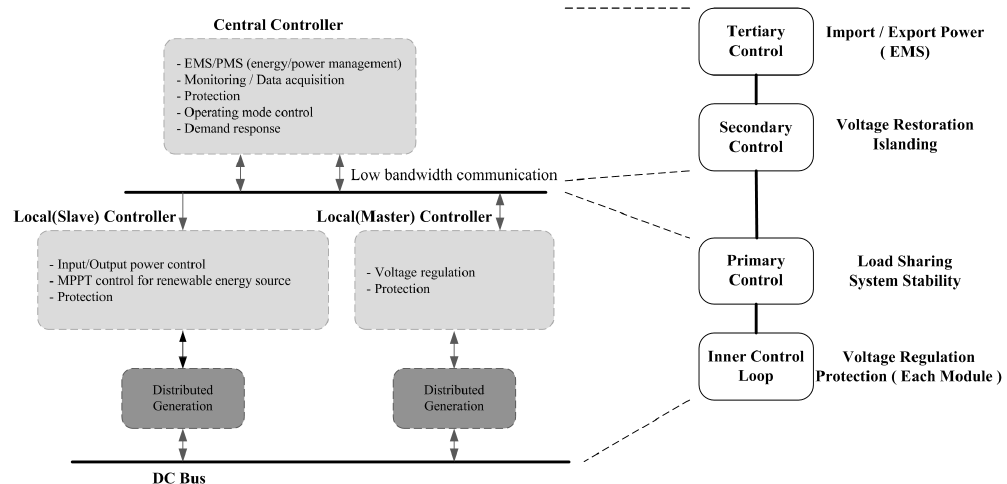
Figure 4. Control structure of the proposed method.